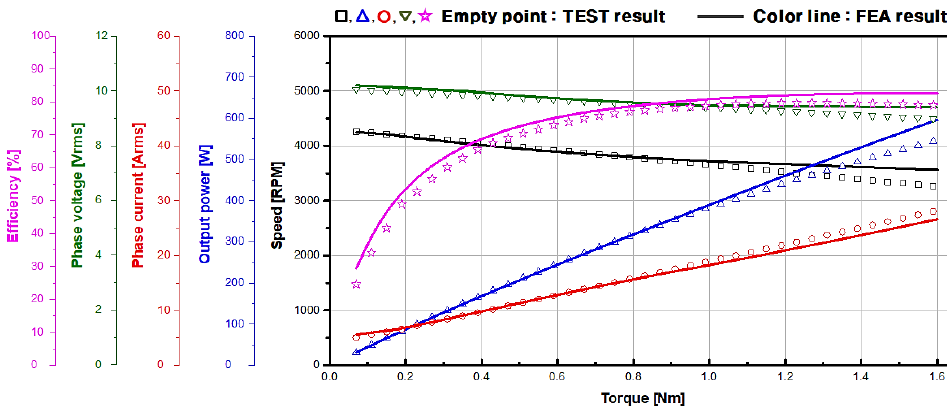
Figure 21. Result of the dynamo load test.